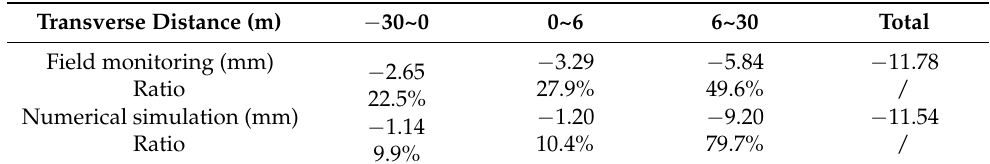
Figure 10. Layered settlement time history curve of stratum at 3m above the tunnel. ( a ) hole 1 #. ( b ) hole 2 #. ( c ) hole 3 #. Table 5. The stratum settlement value at 3 m above the tunnel at different stages of shield tunneling in hole 1 #.